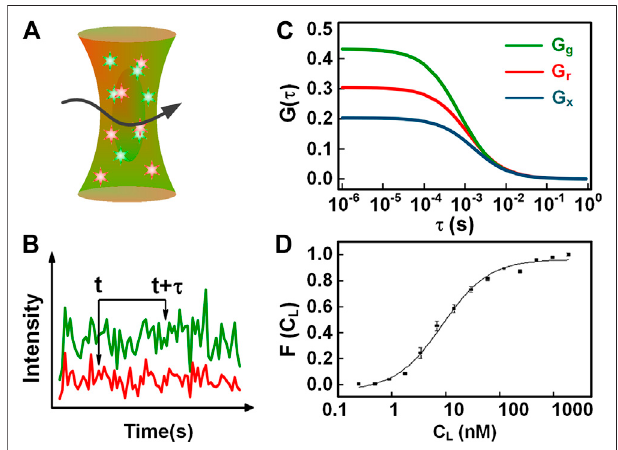
FIGURE 2 | Illustration of dual-color FCCS. ( A ) The detection scheme of dual-color FCCS. ( B ) Two-color intensity traces generated in the red and green channels. ( C ) The autocorrelation and cross-correlation curves of the red and green intensity traces in ( B ). ( D ) The binding curve of the BNP tracerandAb-BC203, i.e. ,thefractionofBNPboundcomplexvaryingwiththe free Ab concentration. The fi t provides a K D (cid:2) 8.9 ± 1.0